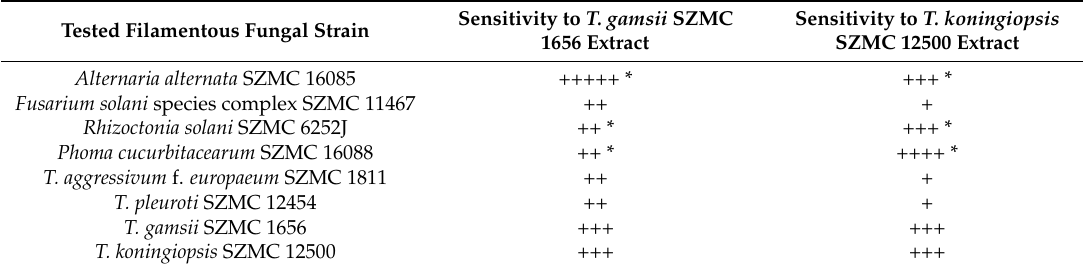
Table 5. Bioactivity of concentrated peptaibol extracts (100 mg mL − 1 ) and their two-fold serial dilutions from Trichoderma gamsii SZMC 1656 and T. koningiopsis SZMC 12500 towards cultures of filamentous